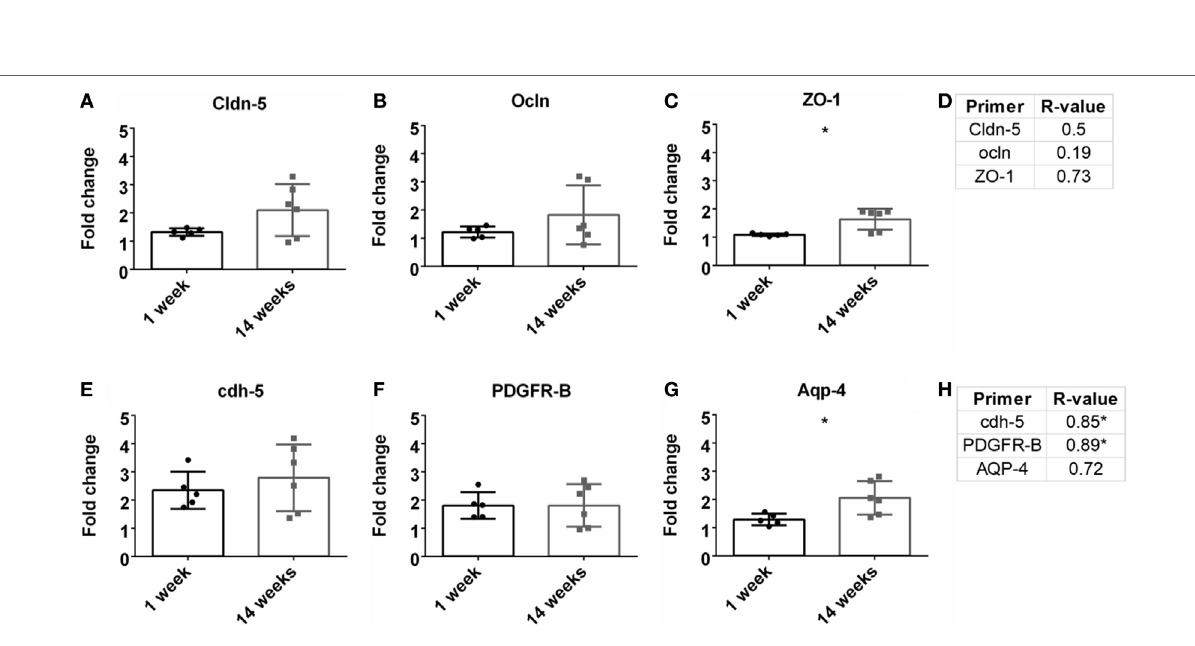
FigUre 5 | Fold change comparisons between 1 and 14 weeks for tight junction proteins (a) Cldn-5, (b) occluding (Ocln), and (c) zona-occludens-1 (ZO-1) and other blood–brain barrier (BBB) markers, (e) cdh-5, (F) PDGFR- β , and (g) AQP-4 (* p < 0.05, Student’s t -test, Bonferroni corrected). Each time point was compared to age-matched naïve controls to calculate fold change. Pearson correlations for (D) tight junction protein markers and (h) other BBB markers (* p < 0.05).